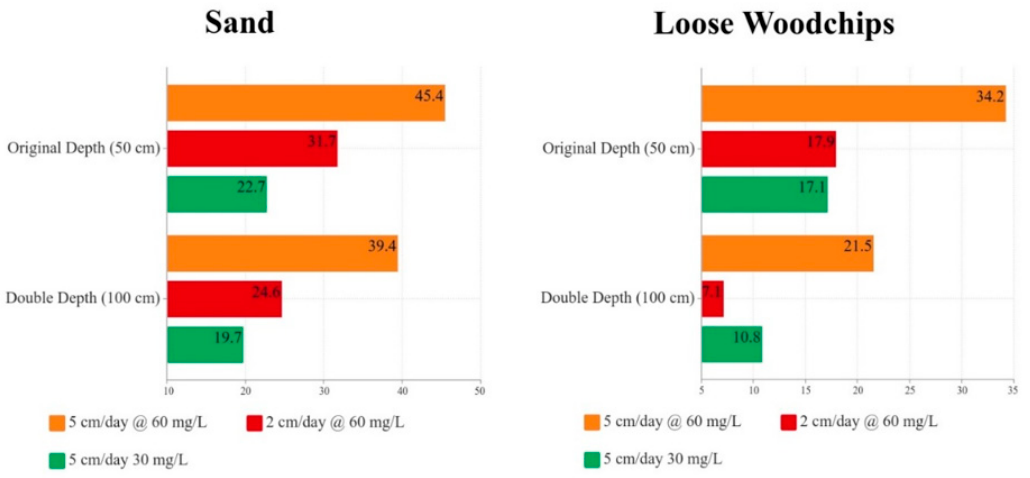
Figure 7. Scenario analysis results.